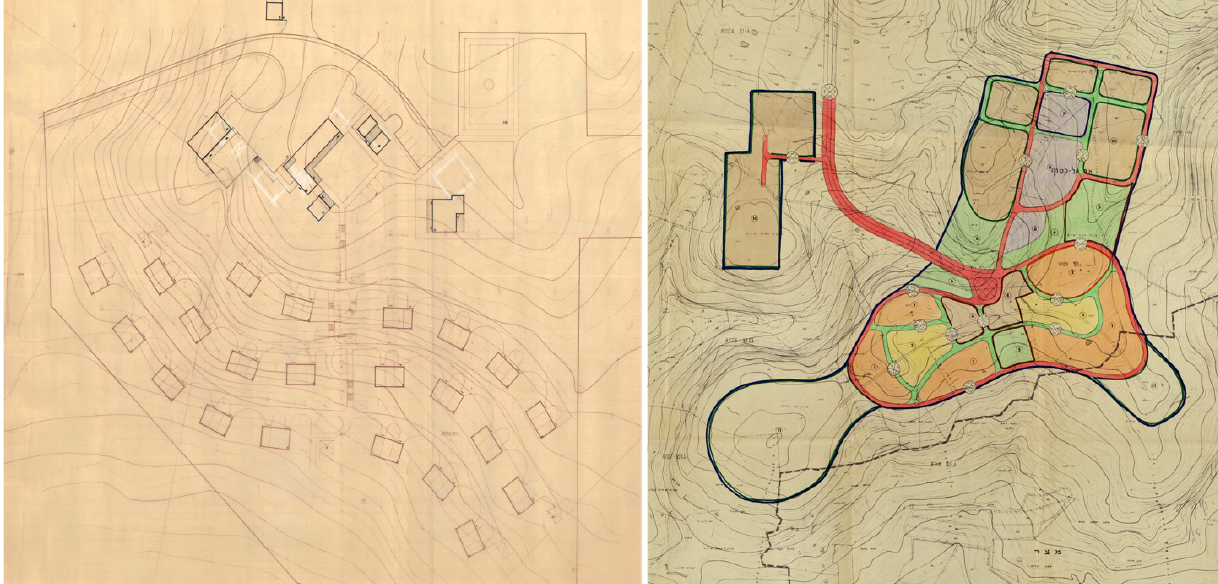
Figure 7. Left: Temporary site of Harish. Right: Outline plan for Kibbutz Harish. Sources: The Jewish Agency for Israel and World Zionist Organisation (1981,